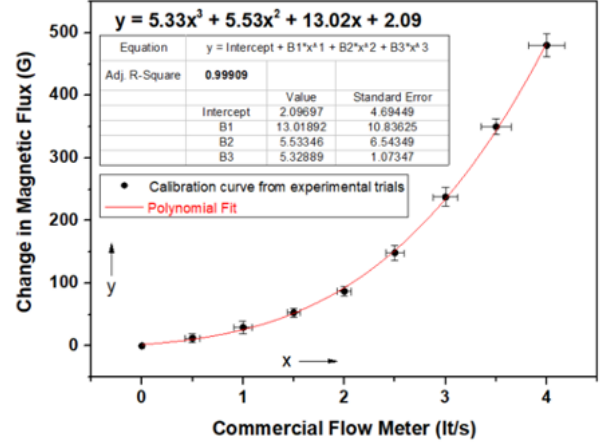
Fig. 4. Comparison of TFMS response against Commercial Flowmeter response for varying flow rates.